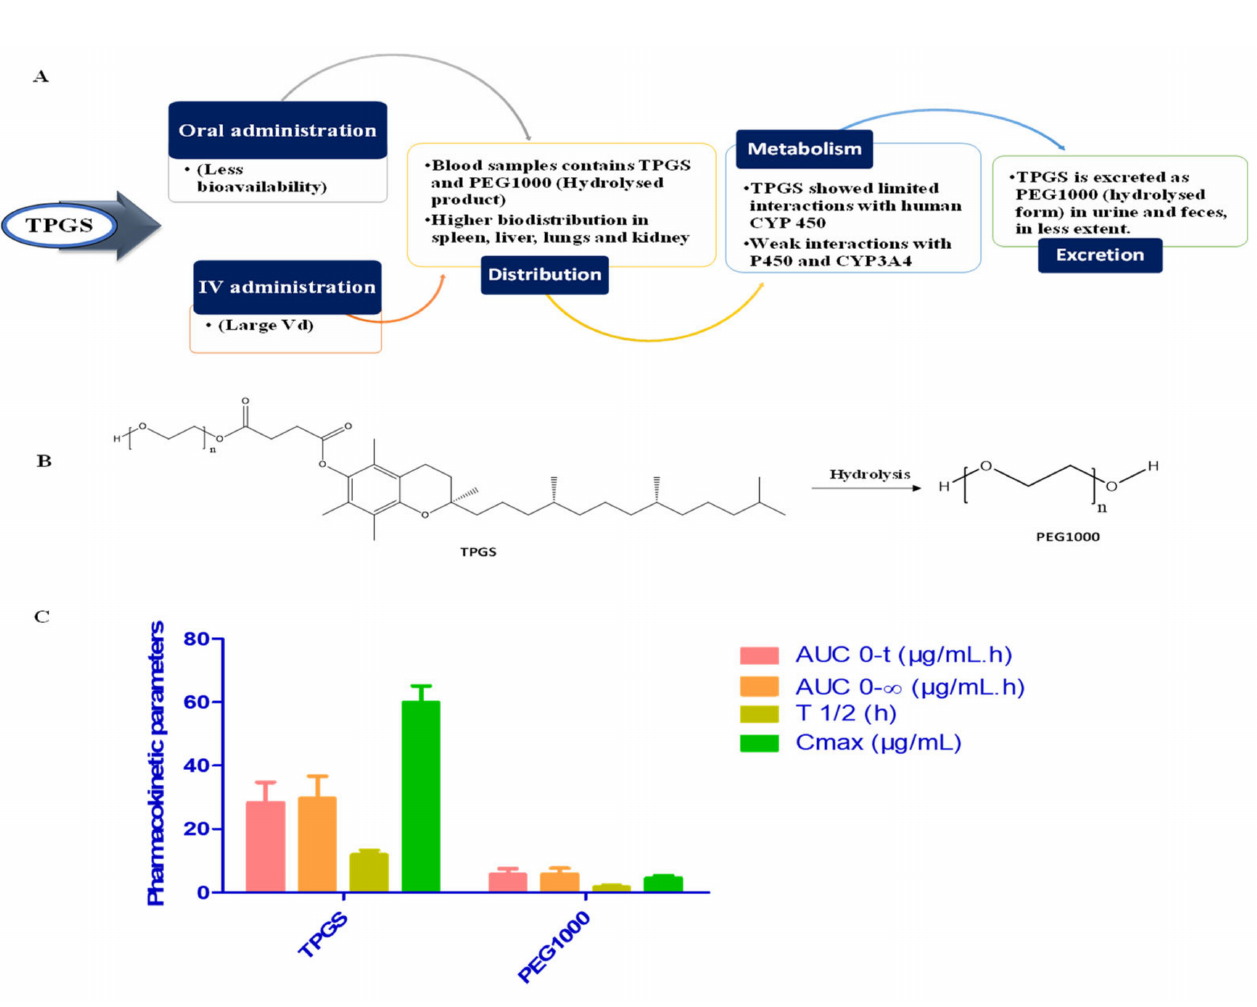
Figure 3. ( A ) Various pharmacokinetic aspects of the TPGS, ( B ) Hydrolysis of the TPGS convert- ing into PEG1000. ( C ) Various pharmacokinetic parameters of the TPGS and its metabolites after intravenous administration of TPGS in rats at the dose of 5